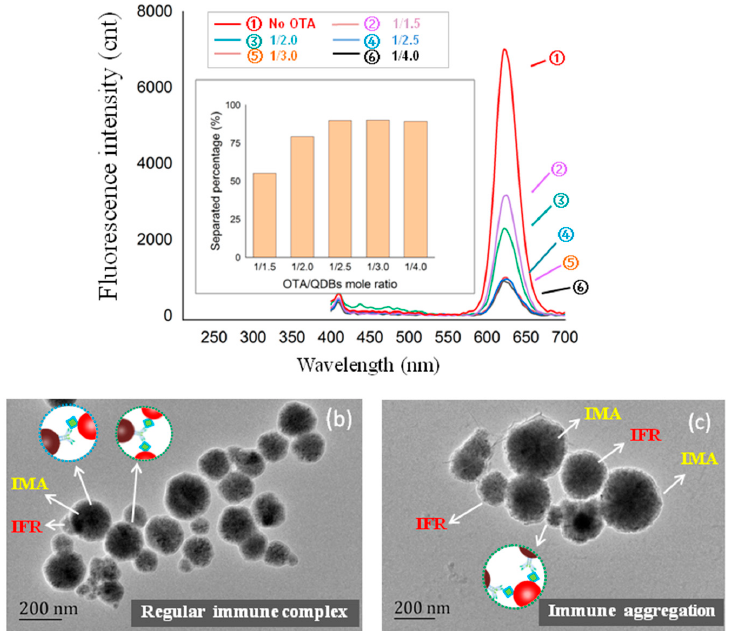
Figure 3. The optimization of the OTA coupling ratio in IFRs. ( a ) The effect of reaction molar ratio of OTA/QDBs on the immuno-separation ratio of IFRs by IMAs. ( b ) The TEM of a regular complex of univalent IFRs (100 nm) and IMAs (200 nm). ( c ) The TEM of the immune aggregation of multivalent IFRs (100 nm) and IMAs (200 nm).